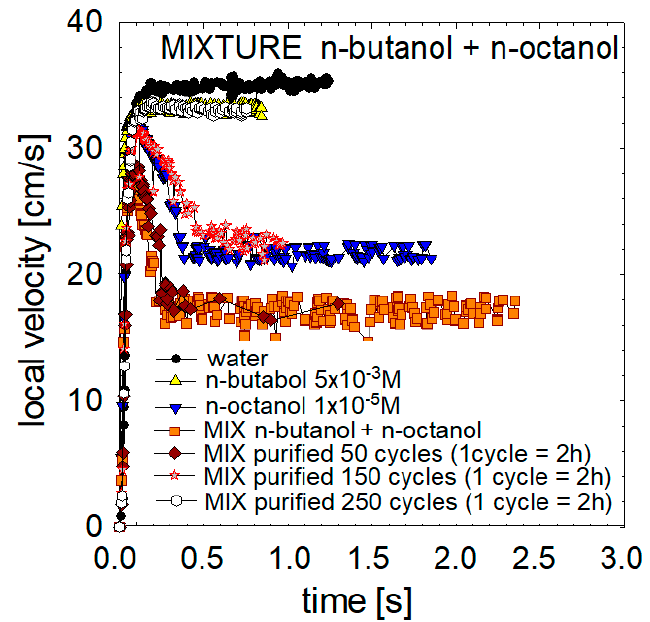
Figure 10. Profiles of bubble local velocities in a mixture of 5 × 10 − 3 M n-butanol and 1 × 10 − 5 M n- octanol.